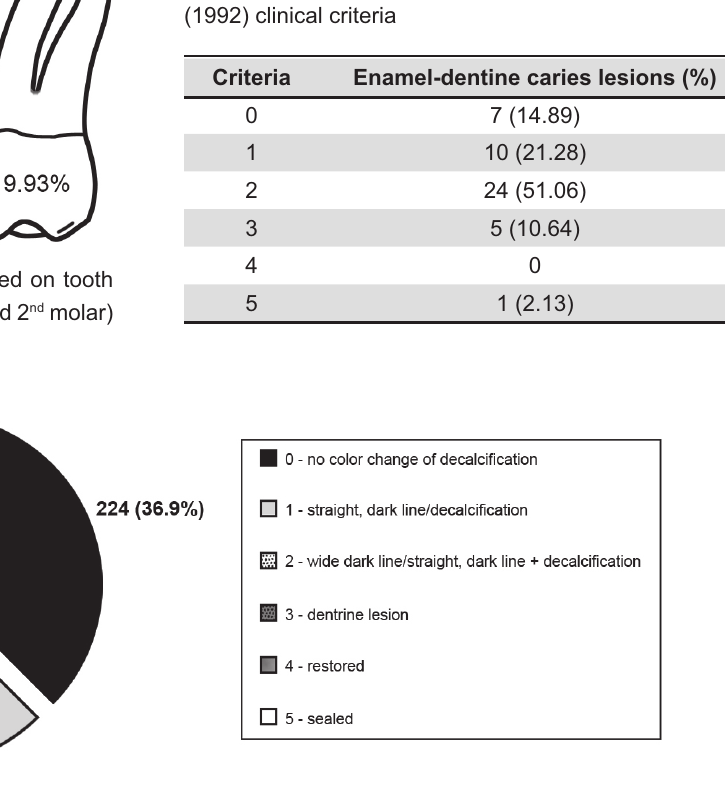
Figure 5- Distribution of Weerheijm, Gruythuysen and Van Amerongen 19 (1992) clinical criteria on the evaluated teeth